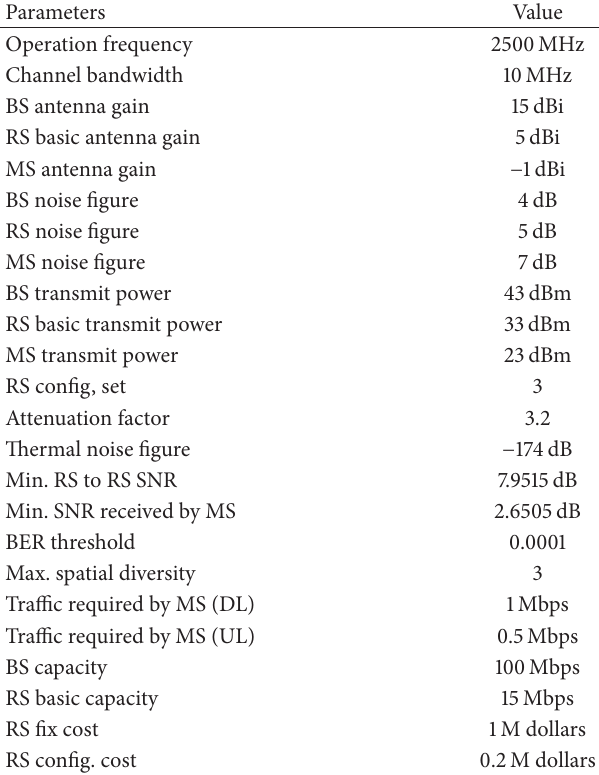
Table 3: System parameters [24, 25].